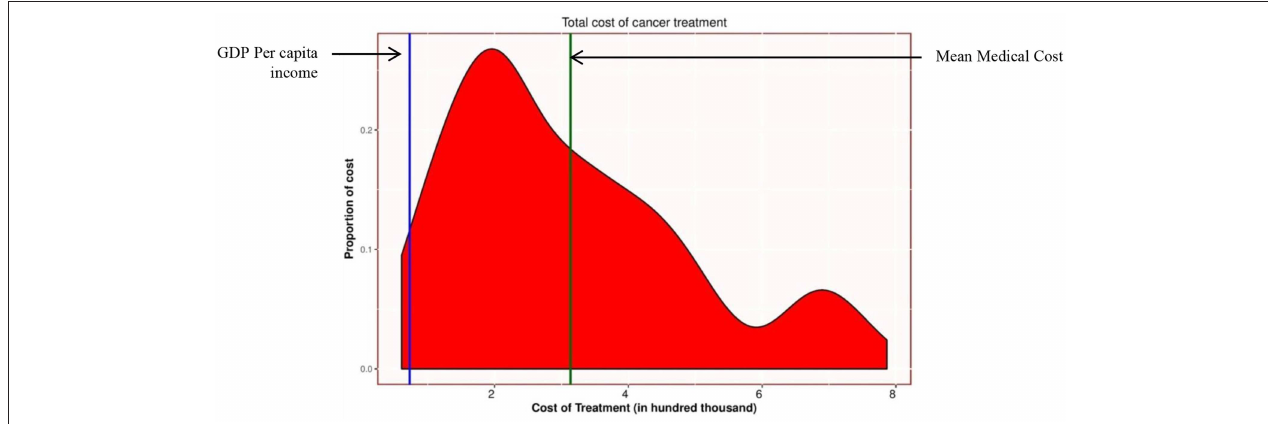
FIGURE 1 | Distribution of medical cost (in NRs ‘000). Green vertical line represents the mean medical cost NRs 313,000.00. (Euro 2,745.6, USD 2,898.14). Blue vertical line represents the per capita income NRs 78,946.00 (Euro 692.5, USD 730.98) (22). During study period (as of 1st Jan 2017), exchange rate for one Euro was NRs one hundred fourteen, and for one US$ was NRs one hundred and eight